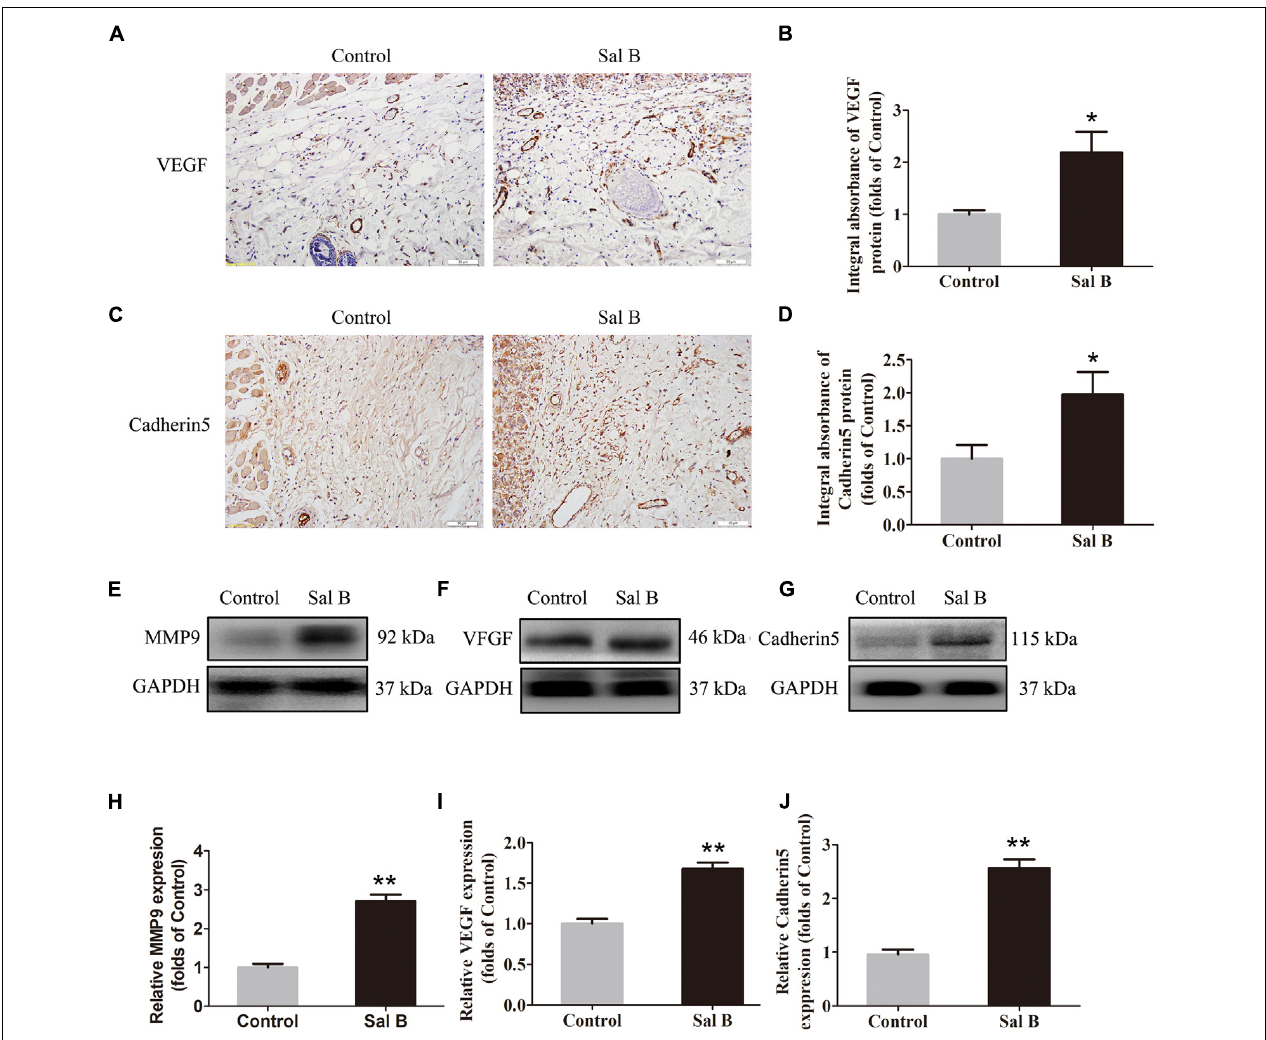
FIGURE 2 | Sal B promotes angiogenesis in ischemic random skin flaps. Rats were killed and the samples in middle part of flap area II were harvested for analysis on post-operative day 7. (A,C) IHC of VEGF and cadherin 5 expression of skin flaps in the Control and Sal B group (original magnification: 200 × ; scale bar: 50 µ m). (B , D) Histograms of optical density values of VEGF and cadherin 5 by IHC, respectively. (E – G) Western blotting of MMP9, VEGF, and cadherin 5 levels of skin flaps in the Control and Sal B group, corrected by GAPDH as internal control. The gels have been run under the same experimental conditions. The original images are available in Supplementary Figure S1A . (H – J) Histograms of optical density values of MMP9, VEGF, and cadherin 5 in the two groups as determined by Western blotting. ∗ p < 0.05 and ∗∗ p < 0.01 vs. the control group. Data are means ± SEM ( n = 6 per